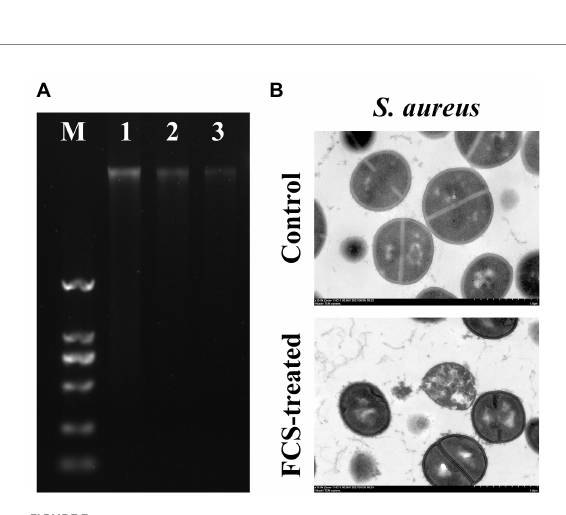
FIGURE 3 The effects of FCS on Genomic DNA of Staphylococcus aureus (A) . Lane M: DL2000 DNA marker; Lane 1: the control group of S. aureus ; Lane 2–3: S. aureus with FCS treatment at MIC and MBC, respectively. The TEM images of S. aureus (B)